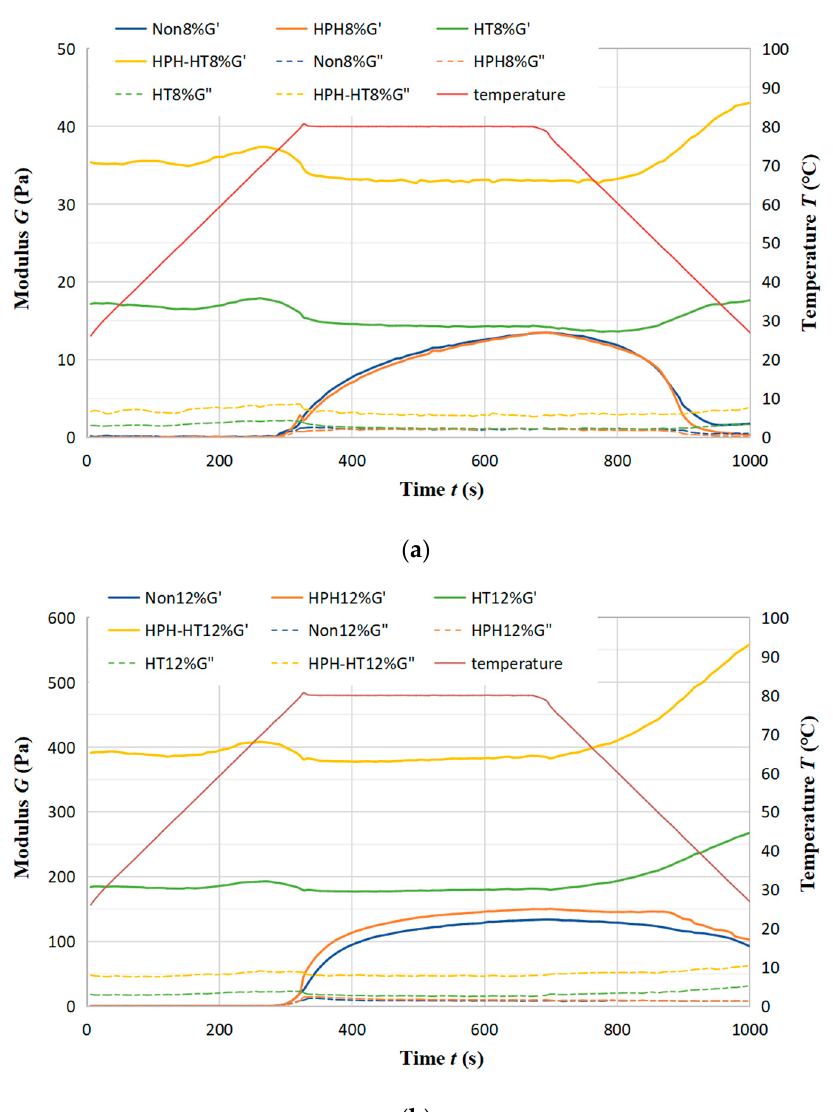
Figure 8. Trend of storage modulus G ′ and loss modulus G ″ of DCF dispersion at concentration 8% ( a ) and 12% ( b ) with time.